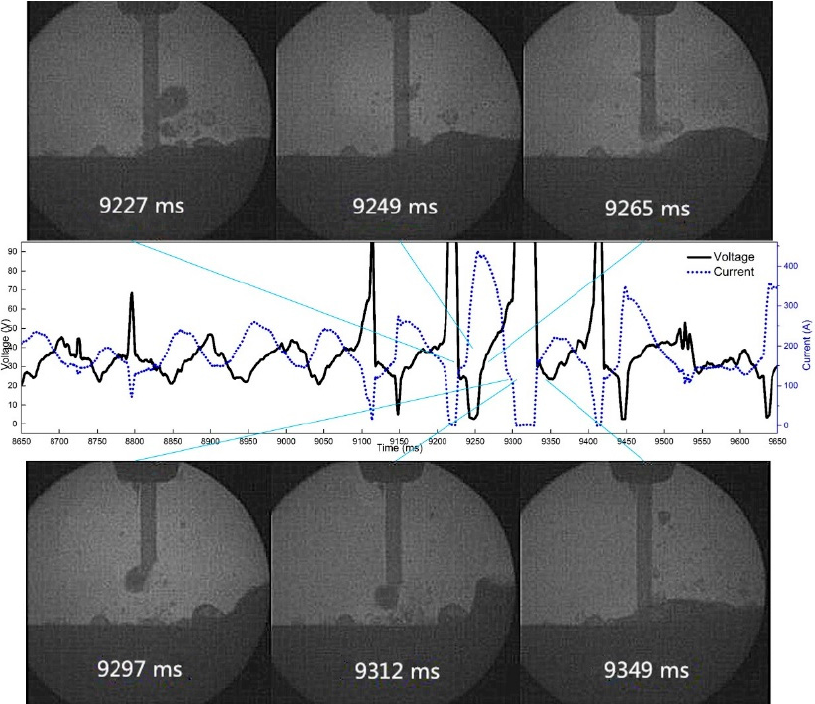
Figure 19. The arc extinguishing process of droplet reburning at 10 Hz and 1.0 mm withdrawal quantity.